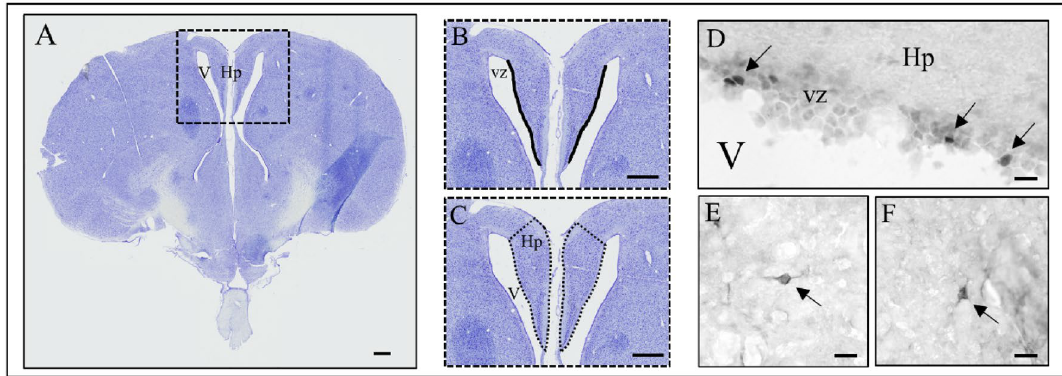
Figure 2. Neurobiological analysis. Scanned quail brain histological section stained with cresyl violet ( A ), with the detail of the counted areas: ventricular zone (vz, black line) of the hippocampus ( B ) and hippocampus (Hp, delimited by dotted lines; V for ventricle) ( C ). High magnification micrographs of PCNA (Proliferative Cell Nuclear Antigen) immunoreactive cells ( D ) and DCX (doublecortin) immunoreactive cells, bipolar immature (E) and multipolar mature ( F ). Arrows indicate specifically labelled cells. Scale bars: 500 µm ( A – C ), 10 µm ( D – F